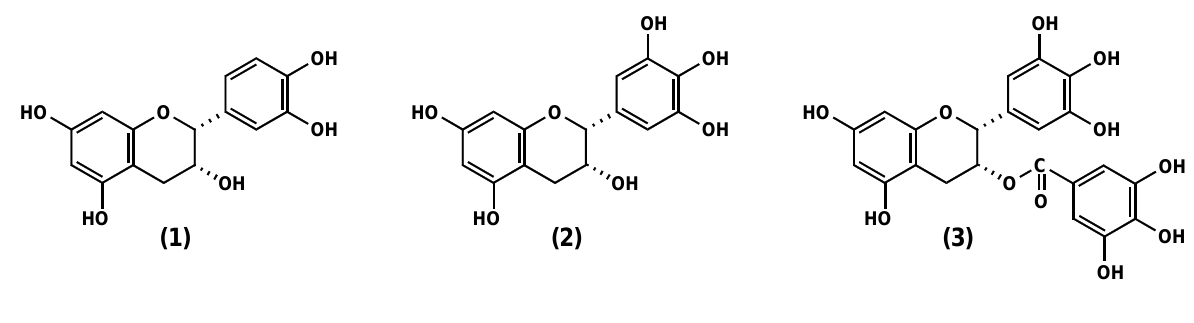
Figure 3. Adhesion of GAS pre-treated with the flavan-3-ols EC ( 1 ), EGC ( 2 ) and